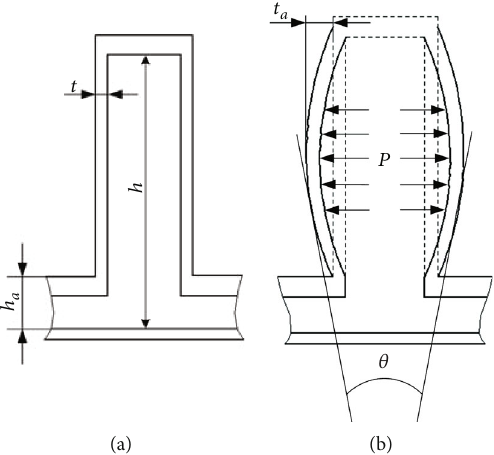
Figure 4: Equivalent diagram of a single driving cavity structure. (a) Initial state. (b) Deformation state.